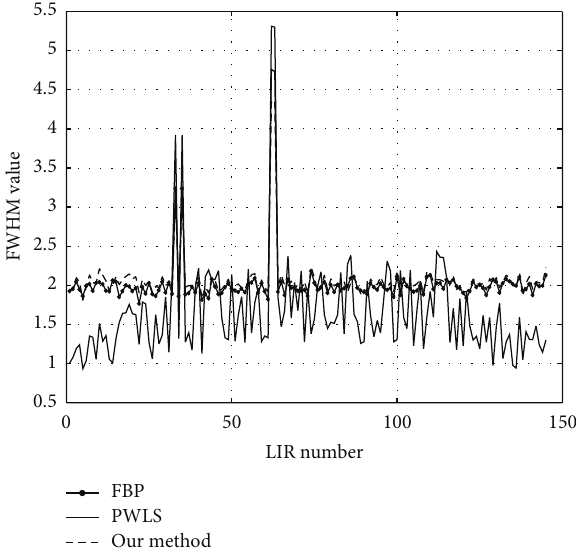
Figure 22: FWHM values in 212 random image